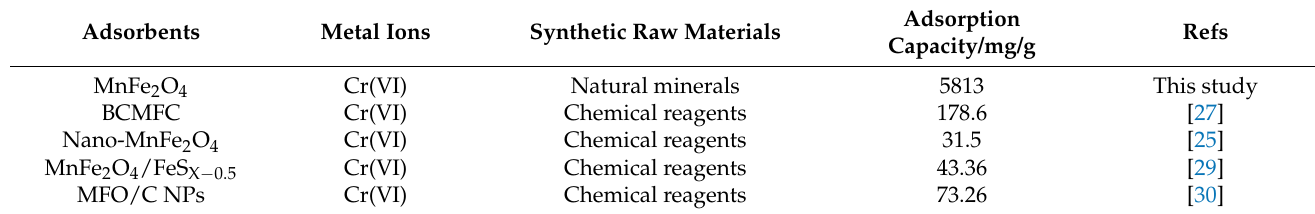
Table 4. The adsorption energy, the shortest distance between Mn/Fe and O, and the charge transfer between MnFe 2 O 4 − H (100) and